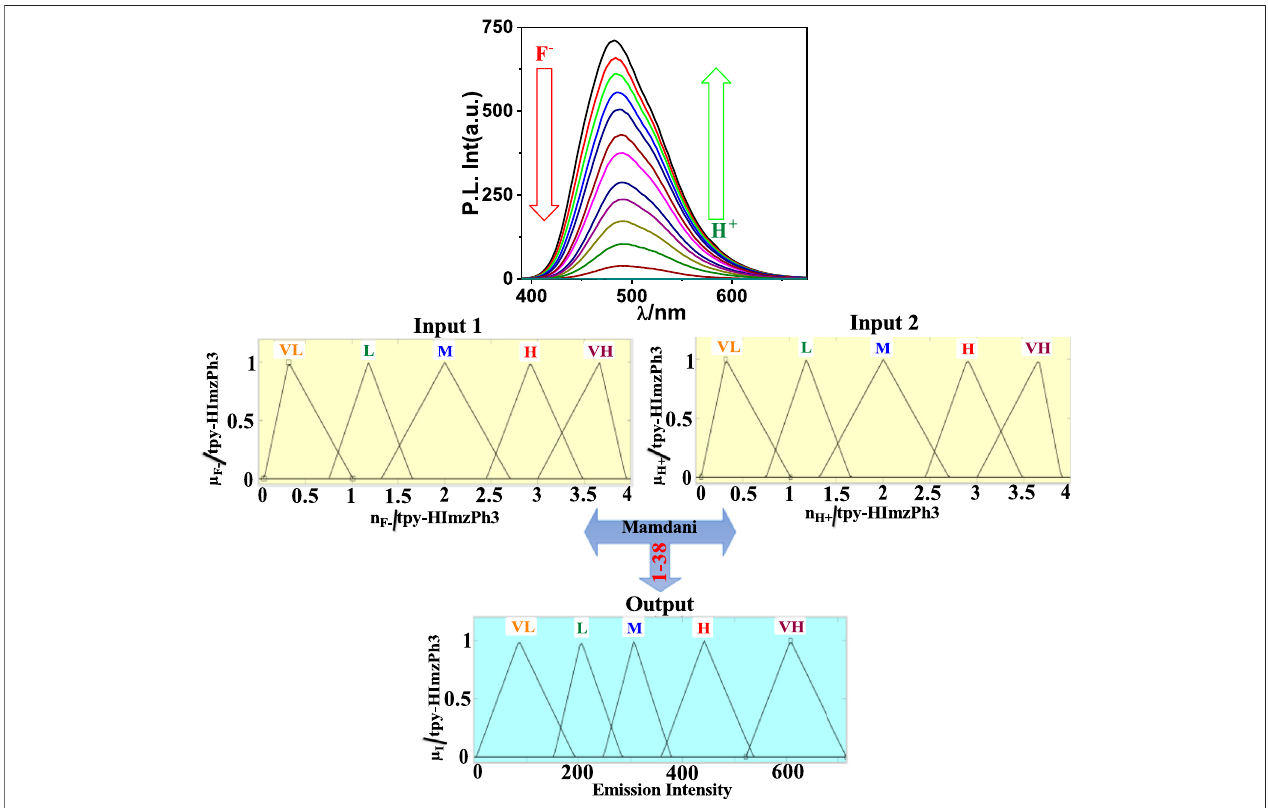
FIGURE 5 | Schematic display of fuzzy logic scheme based on fuzzy inference rules upon monitoring the emission intensity as a function of F − and H + . Fuzzy variablesaredecomposedin fi vefuzzysets.F − :(1)verylow[trimf μ verylow ,(0.0560.321.01)];(2)low[trimf μ low ,(0.7571.181.65)];(3)medium[trimf μ medium ,(1.3222.72)]; (4) high [trimf μ high , (2.45 2.92 3.482)]; and (5) very high [trimf μ veryhigh , (3 3.665 3.95). H + : (1) (1) very low (trimf μ verylow , (0.056 0.32 1.01)]; (2) low [trimf μ low , (0.757 1.18